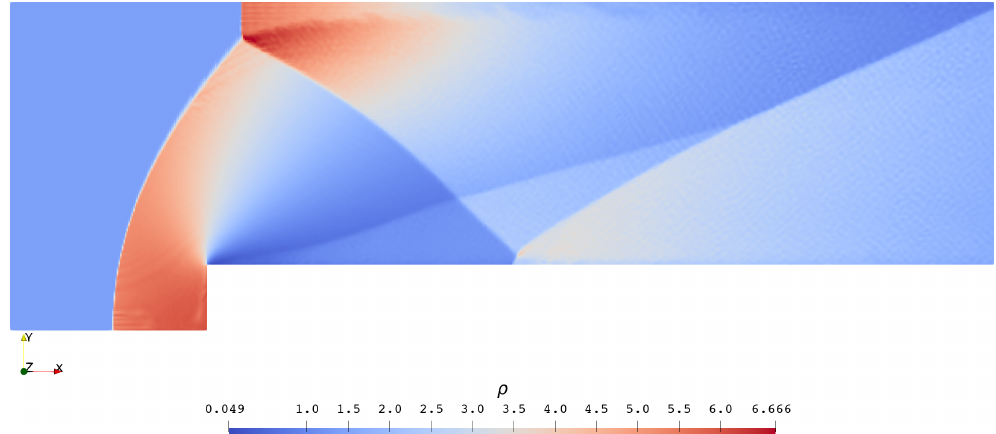
Figure 16. Third-order solution of Problem 4 at t = 2.4 on an h = 1/200 mesh.